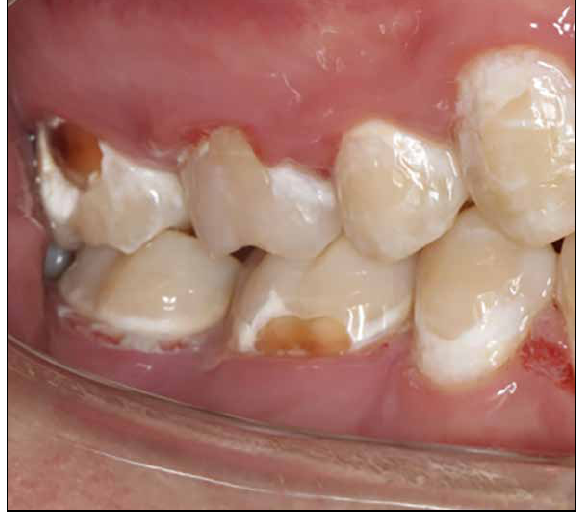
Figure 1. Presentation of white spot lesions (WSLs) at the time of debonding where composite resin adhesive was used. An excellent orthodontic result is compromised with chalky white areas adjacent to gingival margins and cavitation on upper and lower permanent